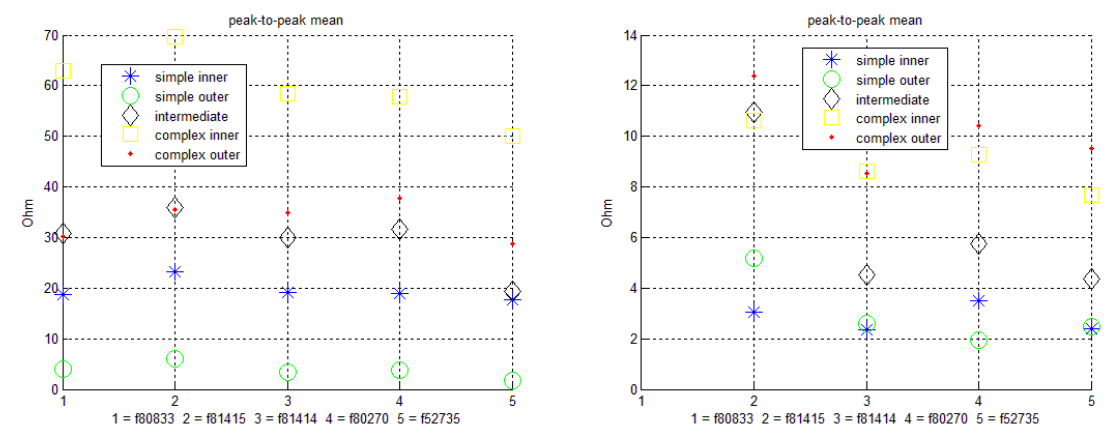
Figure 15. Peak-to-peak mean: ( left ) un-insulated case; ( right ) insulated case.